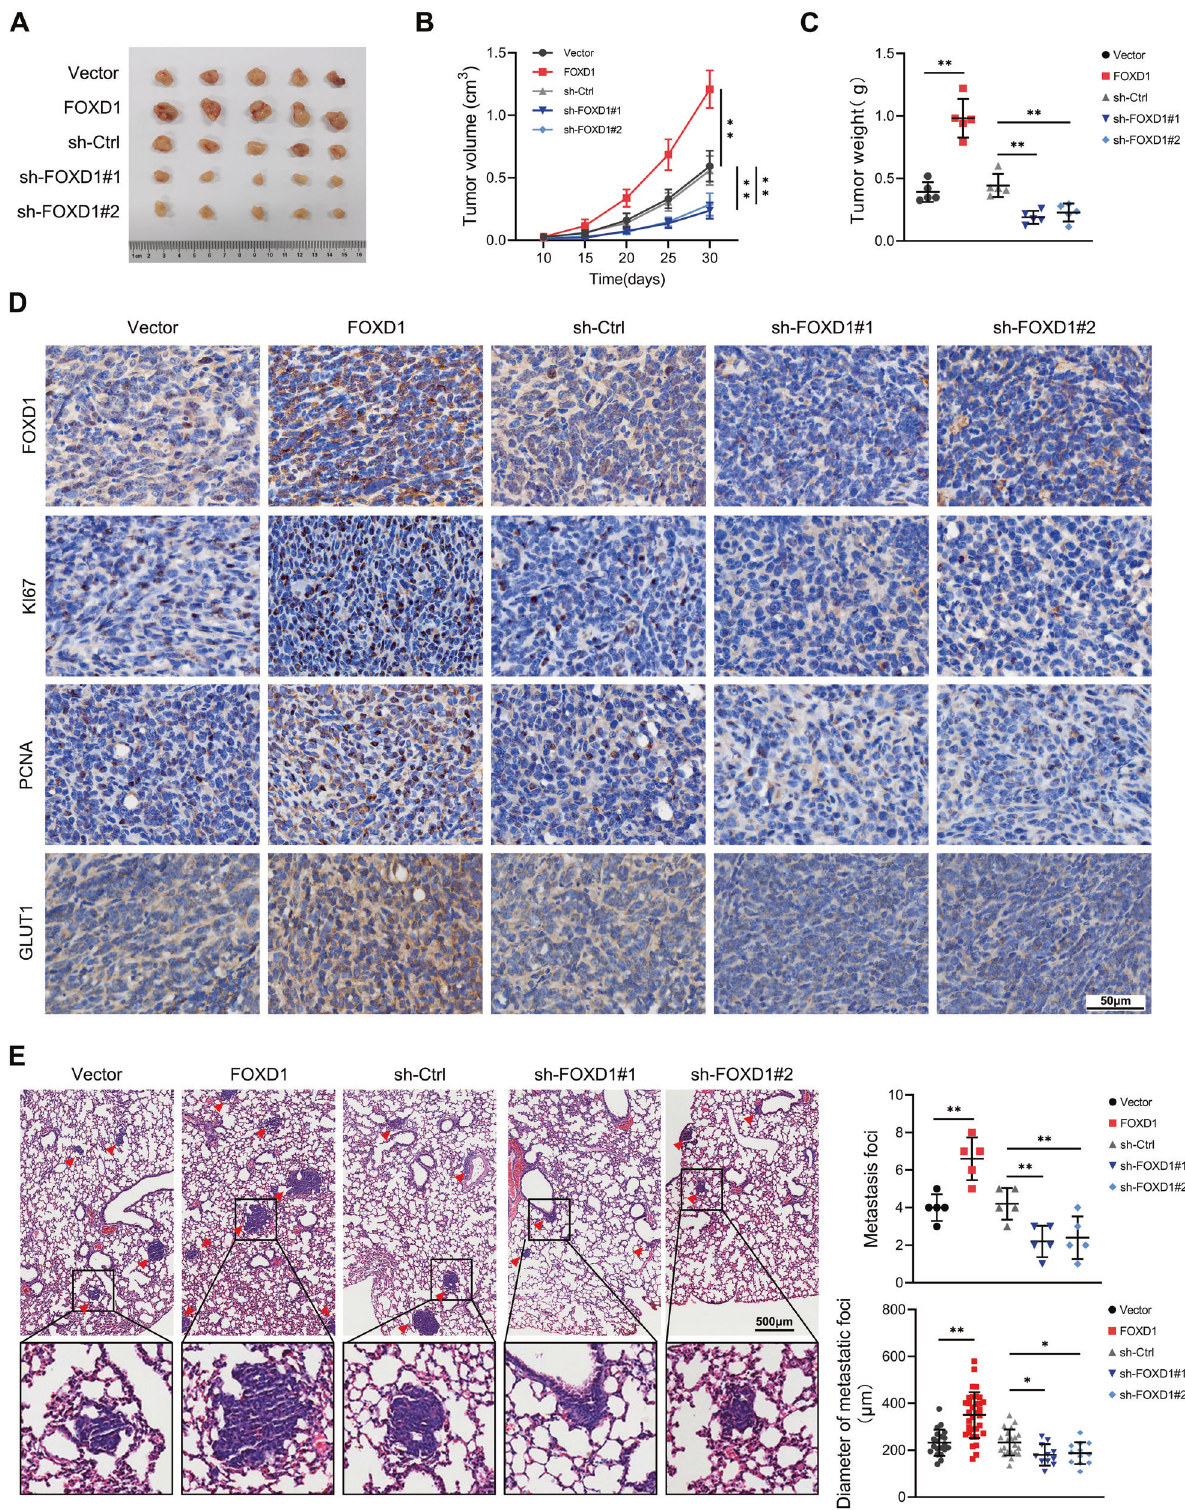
Fig. 3 FOXD1 promotes PC cell proliferation and metastasis in vivo. A Excised subcutaneous tumors 30 days after inoculation with the indicated PANC-1 cells. B Growth curves of subcutaneous tumor volume in each group. C Weight of subcutaneous tumors in each group. D Representative images of FOXD1, KI67, PCNA and GLUT1 expression in subcutaneous tumors detected through IHC. E Representative images of pulmonary metastases in each group. * p < 0.05; ** p < 0.01.